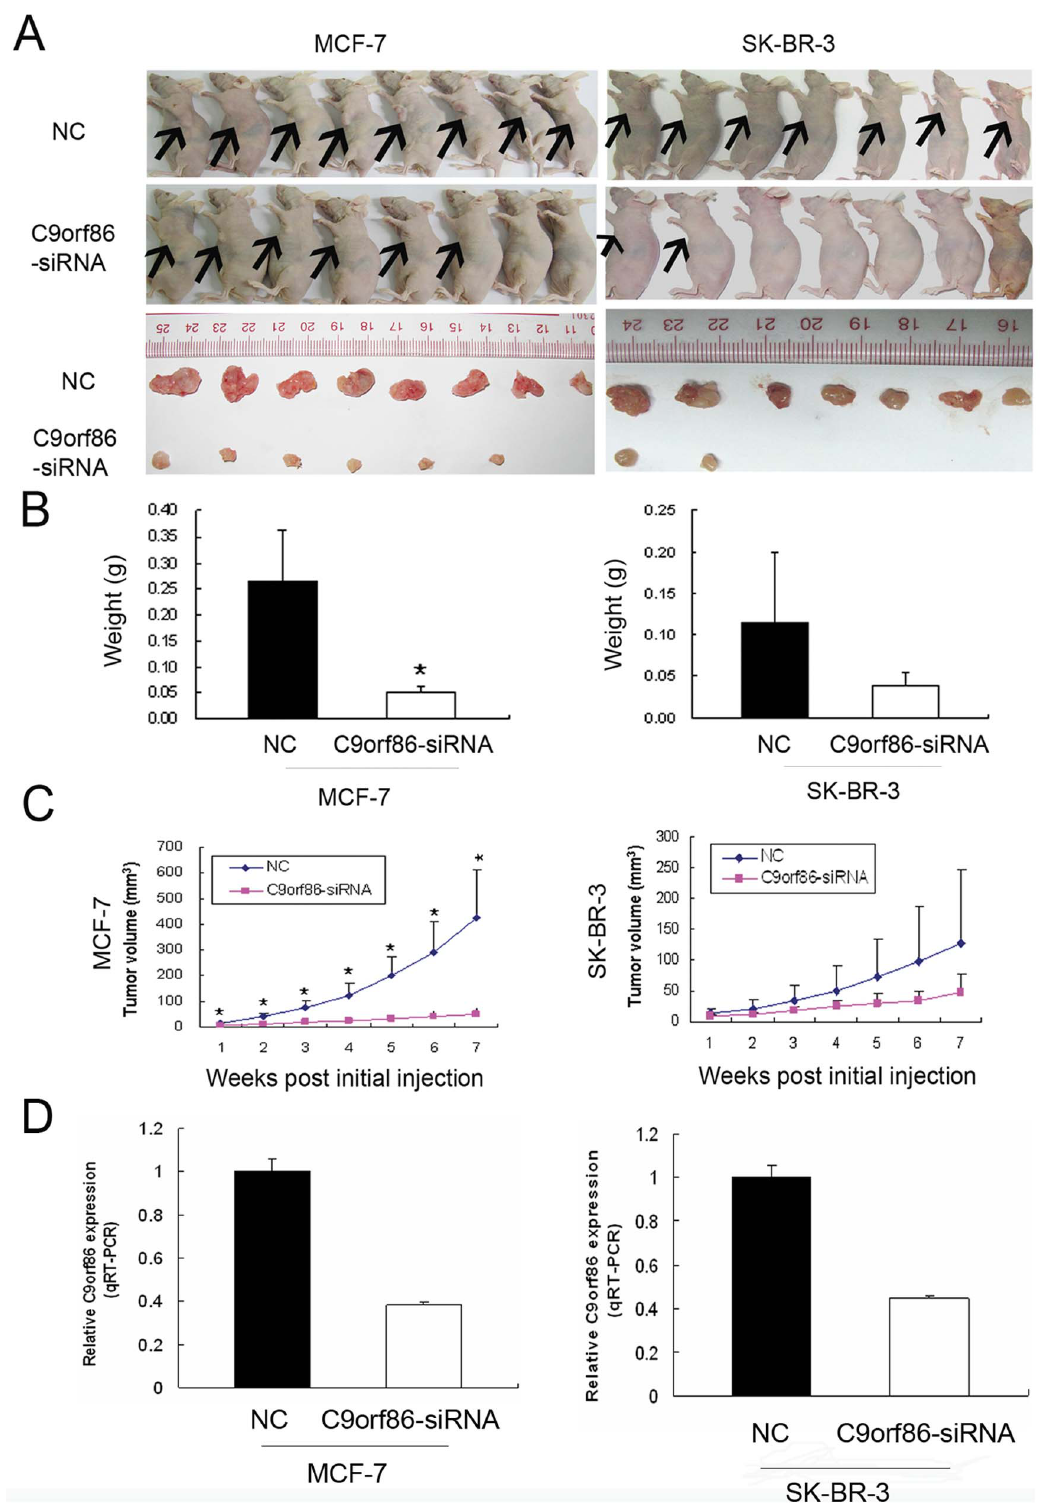
Figure 4. Silencing of C9orf86 induces G1 arrest and apoptosis in breast cancer cells. (A) Cell cycle distribution was analyzed by flow cytometry 72 h after transfection. Bars are shown as the mean 6 SD of cells in G1 phase of the cell cycle. (B) Apoptosis was determined by flow cytometric detection of Annexin-V-FITC-positive/PI-negative cells 72 h after infection. Bars are shown as the mean 6 SD of cells with Annexin-V-FITC- positive and PI-negative. All data are shown as mean 6 SD of two or three independent experiments, *P , 0.05. NC, negative control.